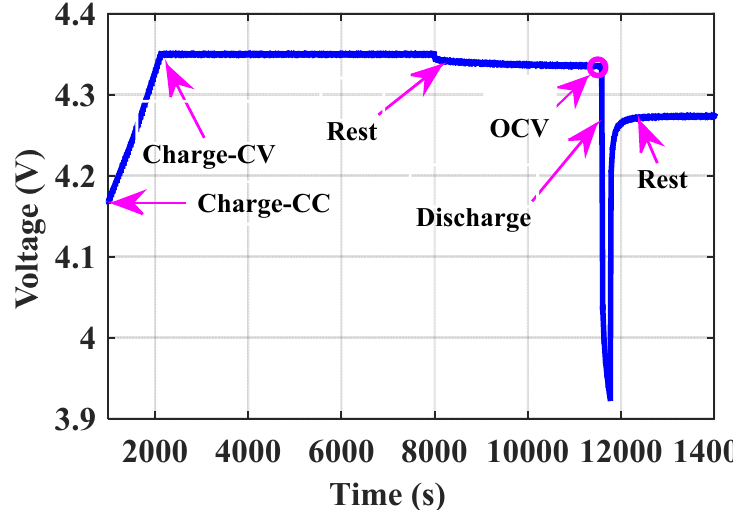
Figure 9. Experimental method for estimation of open-circuit voltage.